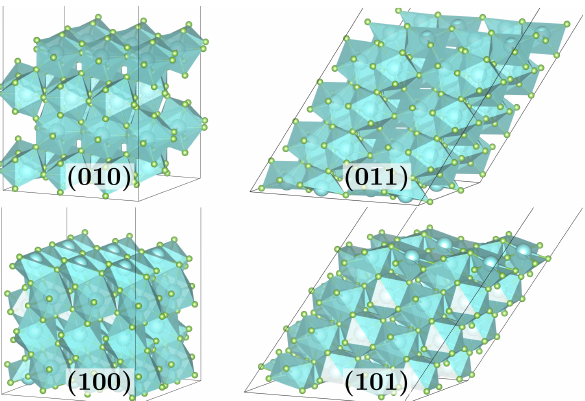
Figure 1. Bare surface supercells as used for the isolated adsorption setup for (010) and (100) of (4 × 3 × 4) MF 3 -layers, as well as (011) and (101) of (4 × 4 × 4) MF 3 -layers for M = Y,